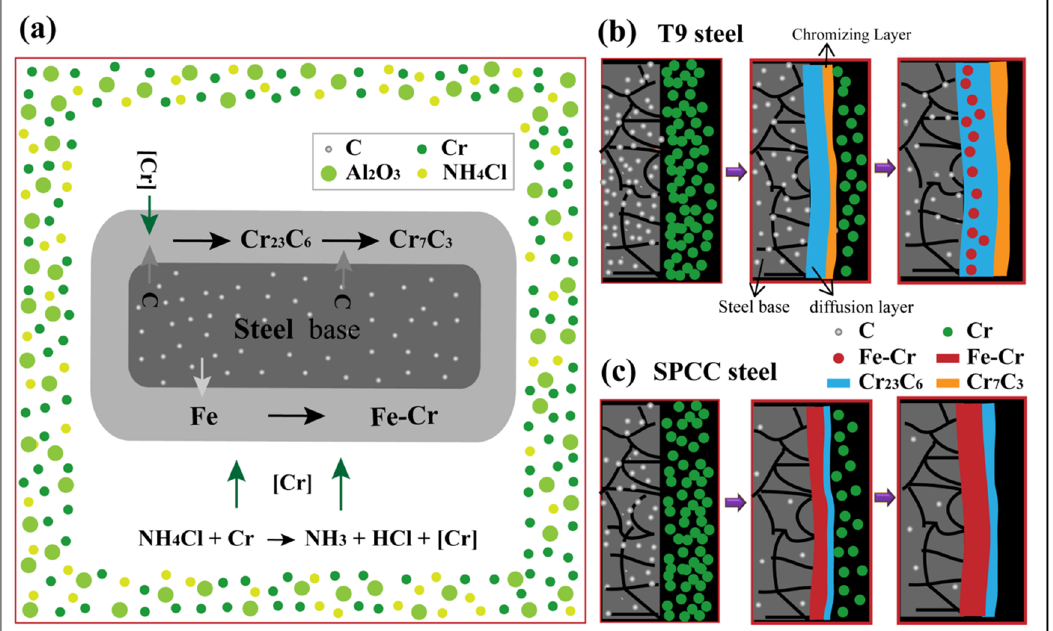
Figure 6. ( a ) Schematic diagram of chromizing reaction of steel matrix; chromizing process diagram of ( b ) T9 and ( c ) SPCC steels.